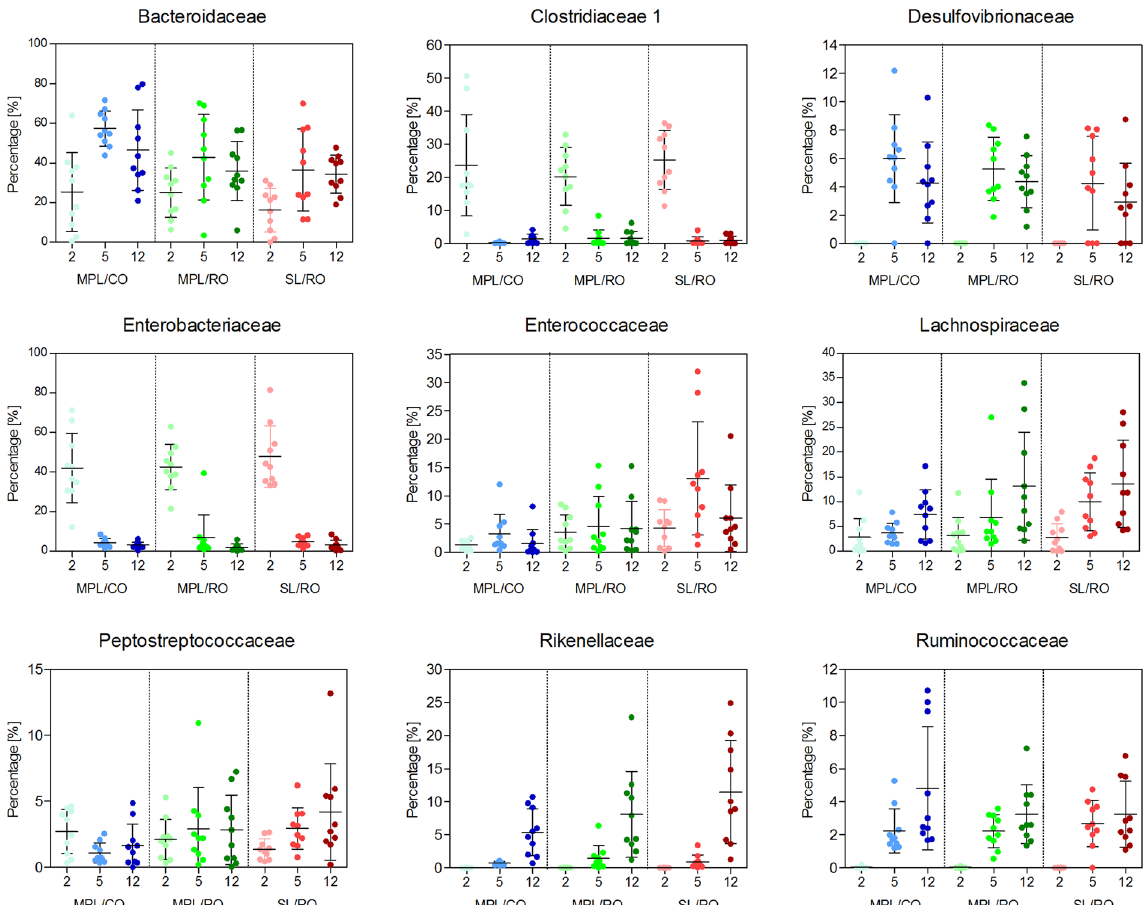
Figure 2. Percentage-wise distribution of bacterial families in fecal samples of mice fed with emulsions. Distribution at bacterial family level in feces samples from Days 2, 5 and 12. Distributions are shown for ( A ) Bacteroidaceae , ( B ) Clostridiaceae 1, ( C ) Desulfovibrionaceae , ( D ) Enterobacteriaceae , ( E ) Enterococcaceae , ( F ) Lachnospiraceae , ( G ) Peptostreptococcaecae , H: Rikenellaceae and I: Ruminococcaceae . Data are shown as mean percentages ( n = 10). Error bars designate standard deviations. No differences were observed between groups within the same day. Note that Y-axis ranges are not identical. MPL: Milk phospholipids, CO: Coconut oil, RO: Rapeseed oil, SL: Soy